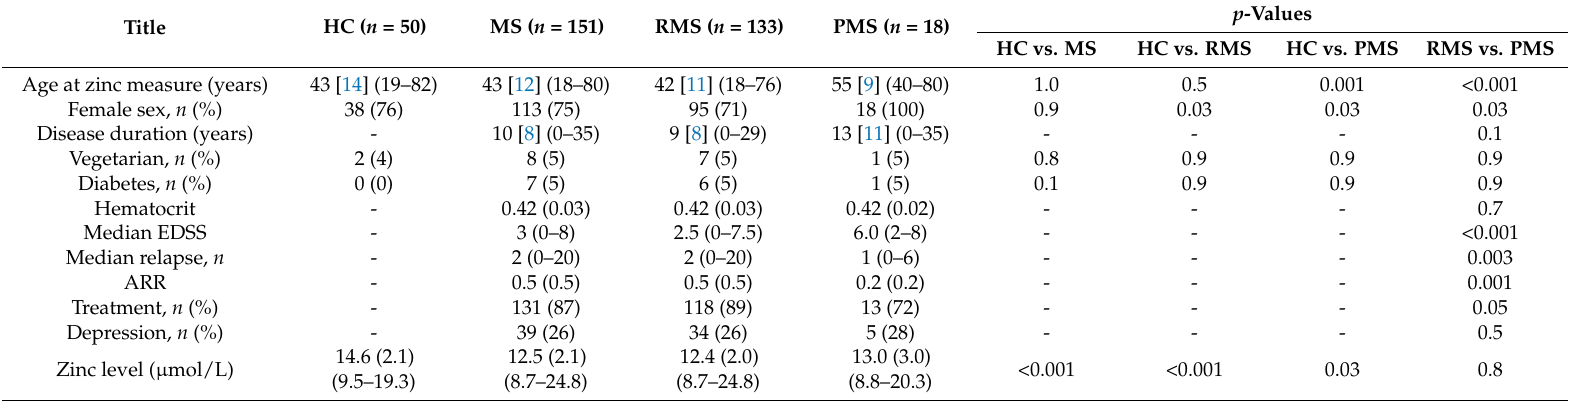
Table 1. n = number of participants; unless otherwise reported mean [standard deviation] is given. ARR = annualized relapse rate, HC = healthy controls, MS = multiple sclerosis, PMS = progressive multiple sclerosis, RMS = Relapsing multiple sclerosis. Disease duration was defined as the timespan between diagnosis and the date of blood sample. For group comparisons a c 2 -test, an independent-samples t-test or a Mann-Whitney-U test were performed. Moreover, ANOVA with post-hoc Bonferroni-testing was conducted. p -values < 0.05 were deemed to be statistically